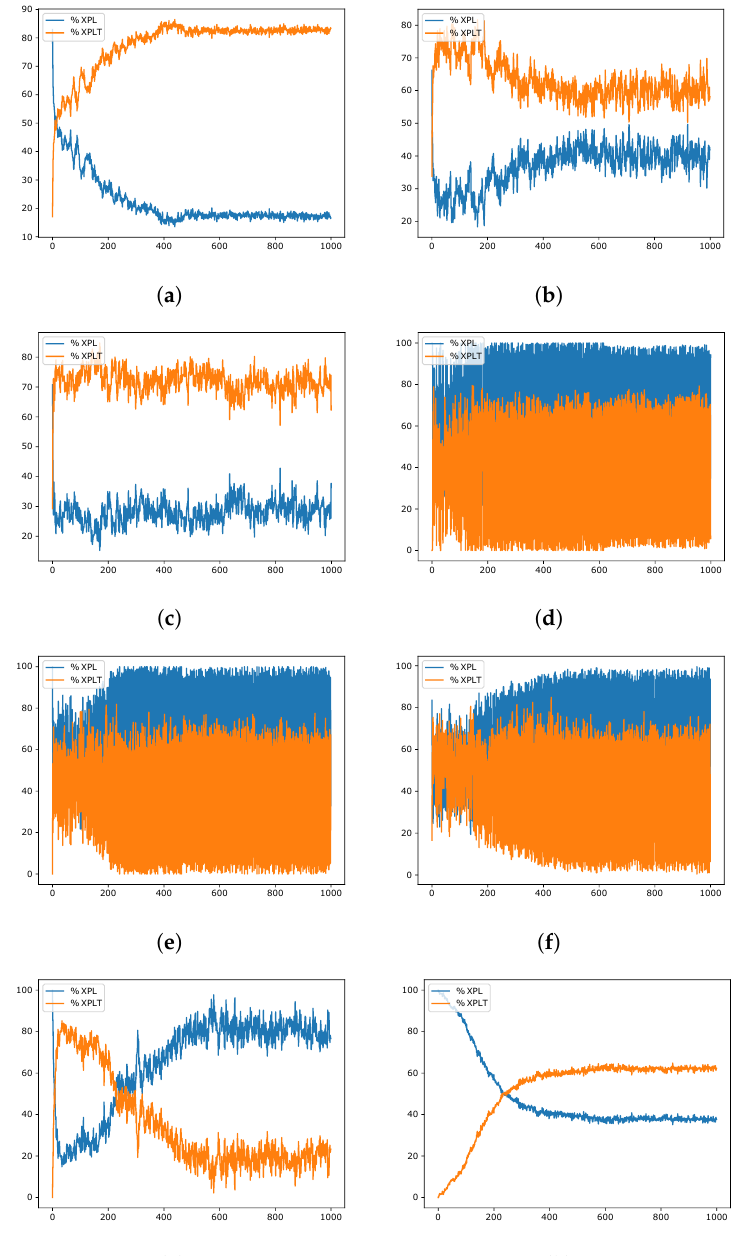
Figure 8. GWO instances exploration–exploitation percentages when resolving the scp51 instance of the SCP. Instance Optimum: 253. ( a ) 80aBQSA—fitness obtained 255; ( b ) 80aQL—fitness obtained 256; ( c ) 80aSA—fitness obtained 256; ( d ) 40aBQSA—fitness obtained 254; ( e ) 40aQL—fitness obtained 258; ( f ) 40aSA—fitness obtained 257; ( g ) BCL—fitness obtained 259; ( h ) MIR—fitness obtained